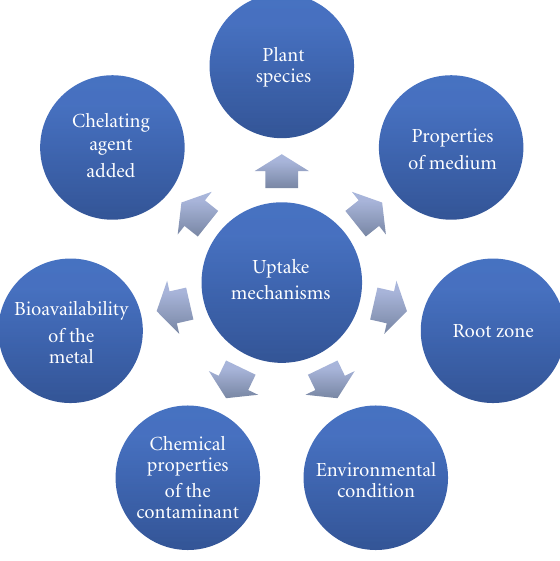
Figure 3: Factors which are a ff ecting the uptake mechanisms of heavy